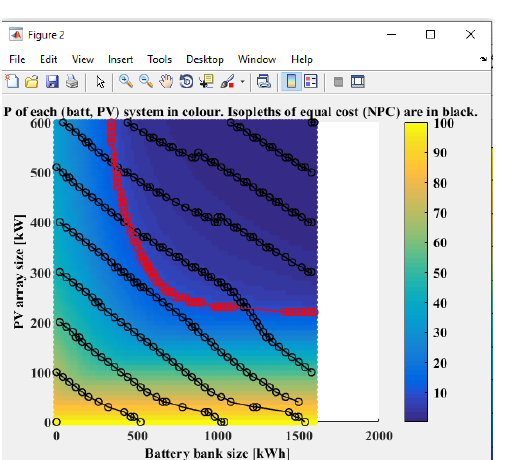
Figure 8. Battery size vs PV Array size causing Isodepth of equal cost NPC in black up to 5000